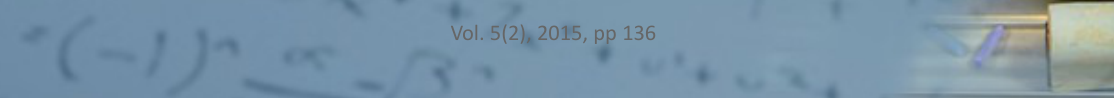
In short, surveys have provided valuable informaton that will enhance the subject in future